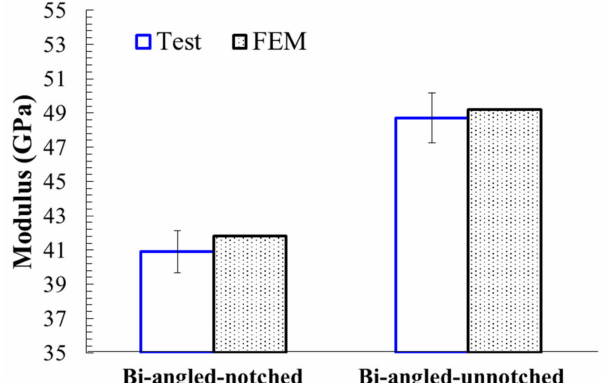
Figure 12. Modulus of the notched and unnotched UACS laminates with bi-angled slits obtained from numerical simulation and